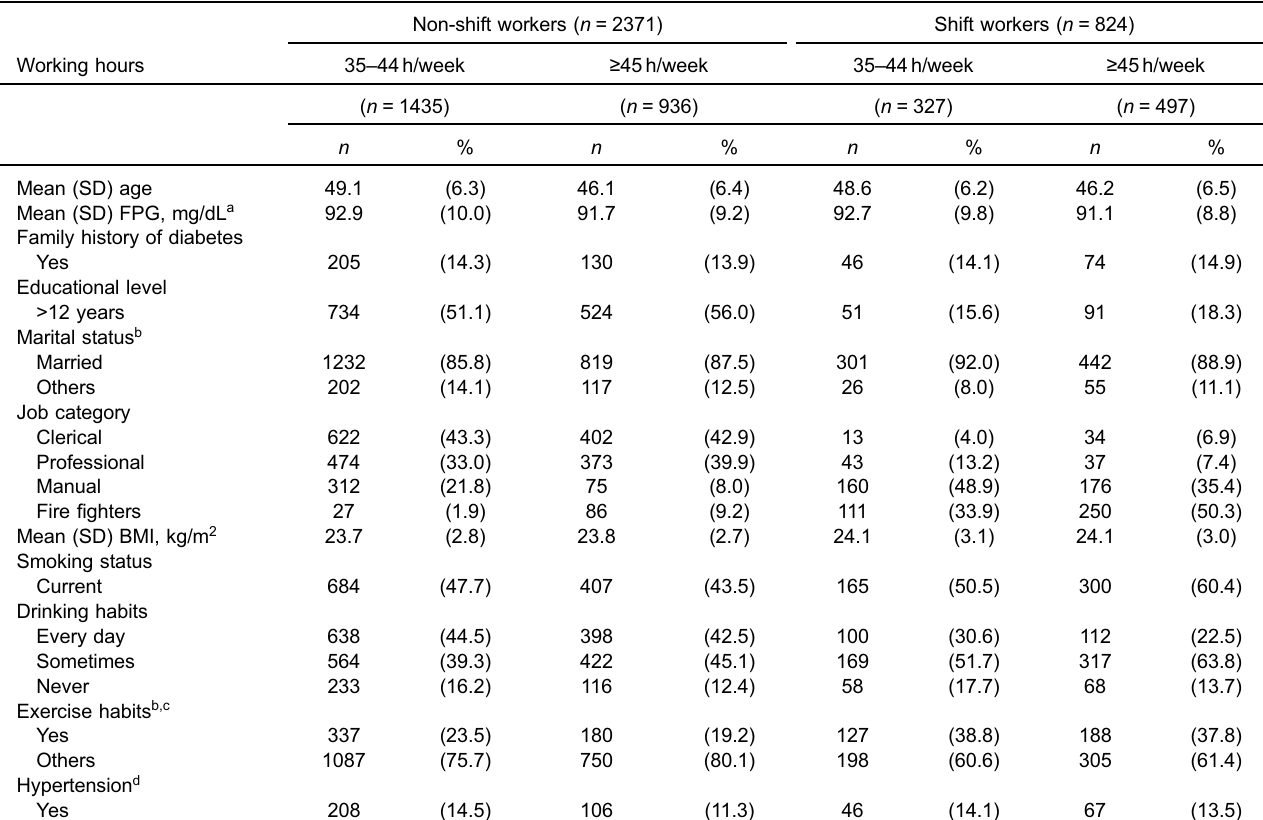
Table 1. Baseline characteristics of male participants according to shift work schedules and working hours ( n = 3195) Non-shift workers ( n = 2371)